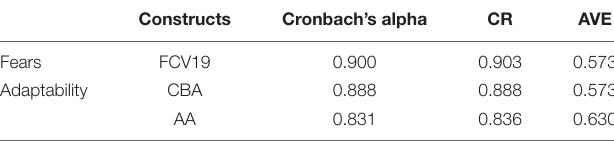
TABLE 5 | Evaluating the reliability of research instruments.